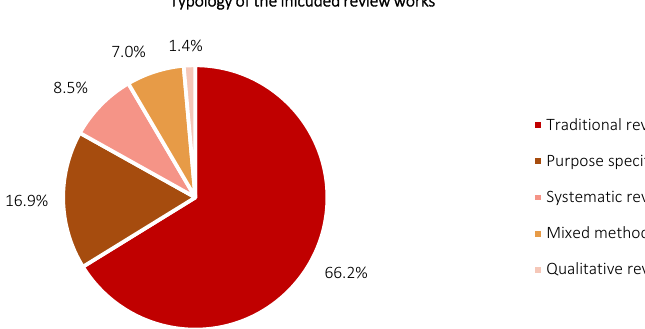
Figure 5. Typology of the included review works.